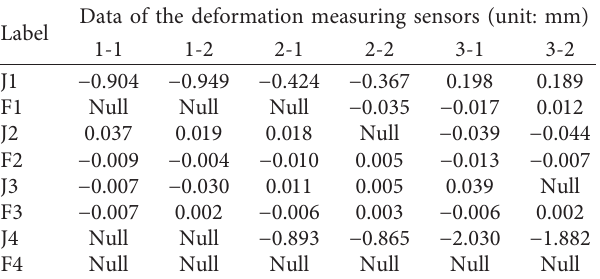
Table 4: Interlayer deformations of the unballasted tracks. Data of the deformation measuring sensors (unit: Label